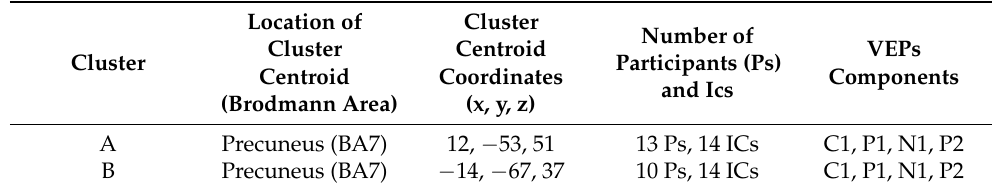
Table 3. Clusters of independent sources contained posterior component P2 obtained with ICA.